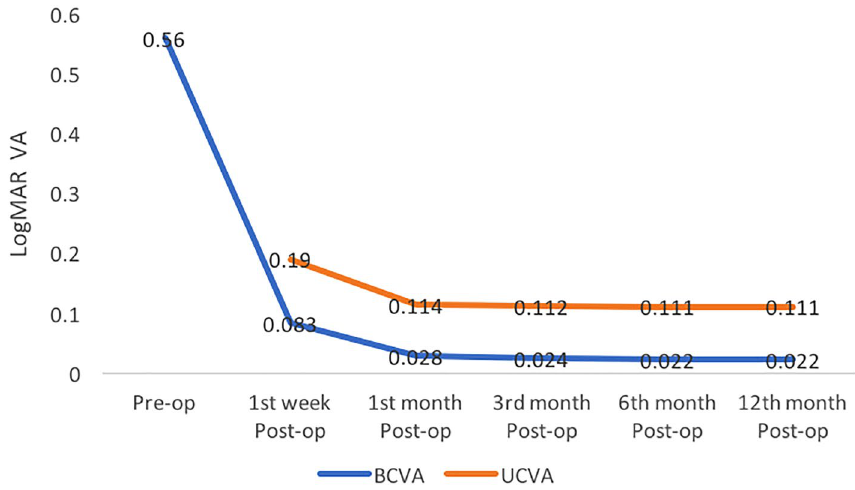
Figure 2. Mean uncorrected and best corrected visual acuity (UCVA and BCVA) over time at all post324 operative visits in LogMAR.